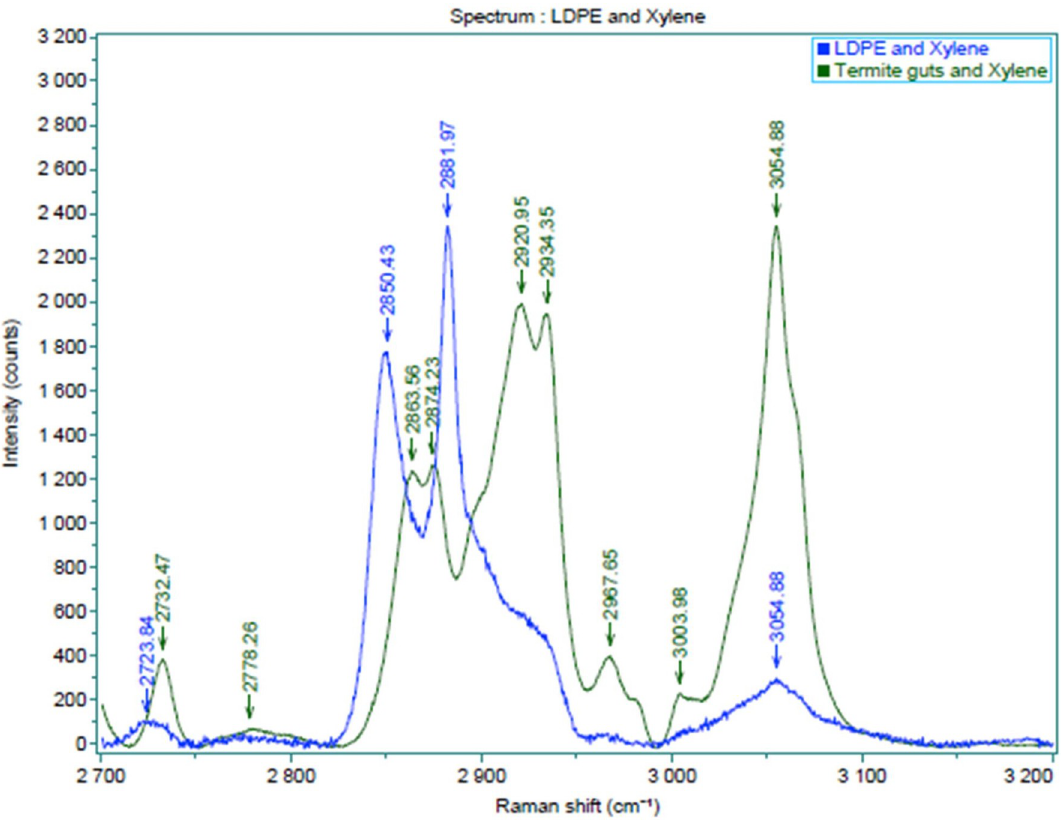
Fig 12. Raman spectra suggesting LDPE inside termite guts (blue color indicates LDPE in xylene as reference; green color indicates termite guts dissolved in xylene).